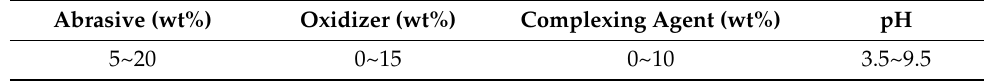
Table 2. Optimization range of polishing slurry composition.